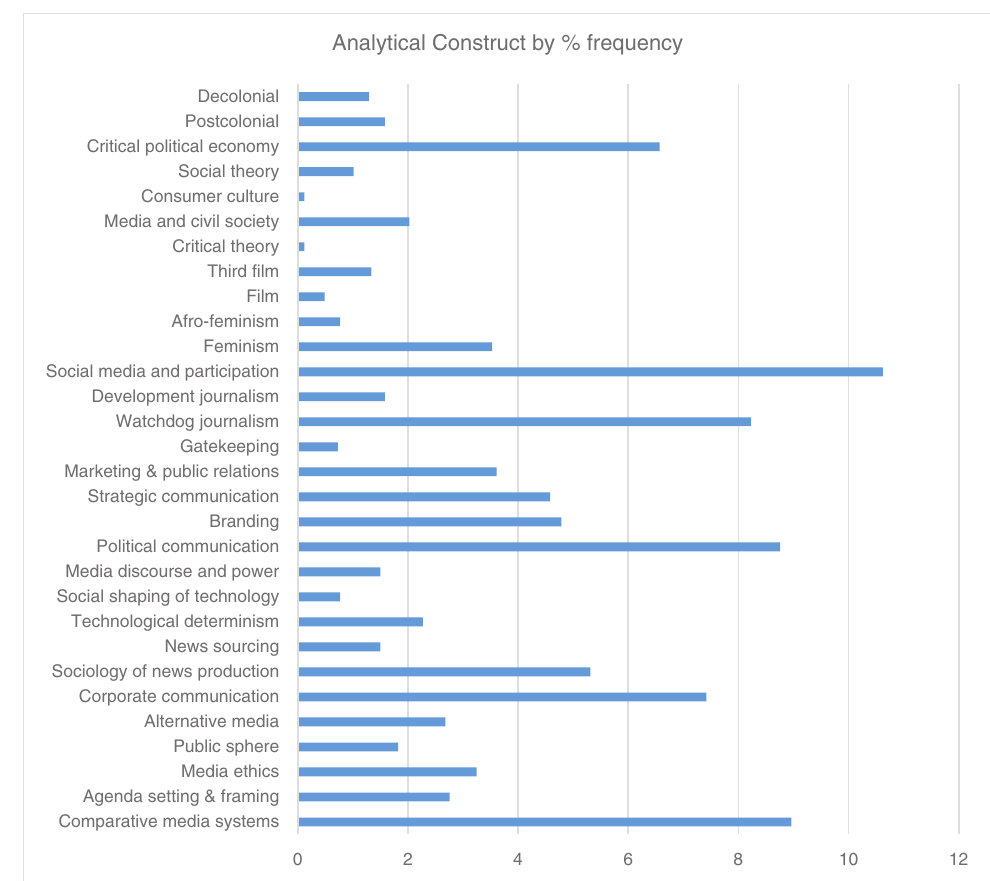
Figure 2: Comparative frequency of media analytical frameworks referenced in PhD theses (Source: Author,